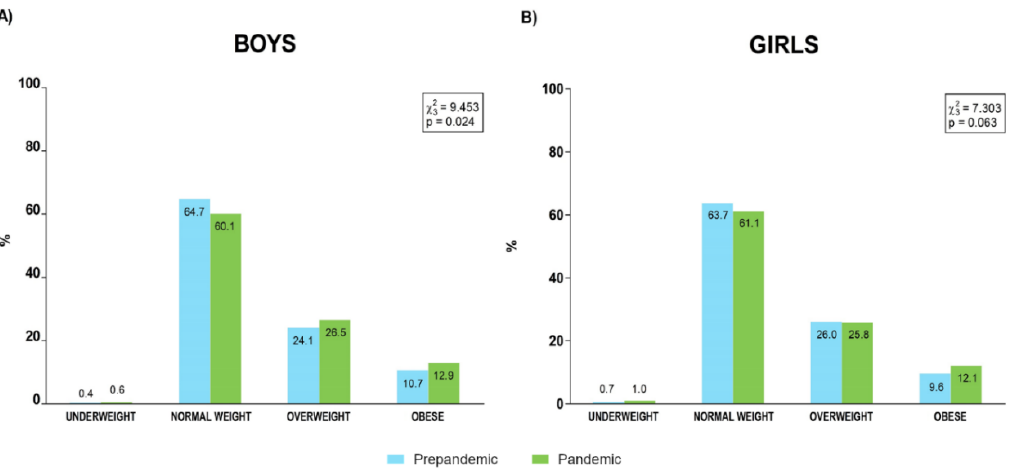
Figure 5. Prevalence of body mass index categories for boys ( A ) and girls ( B ) before and during the pandemic.